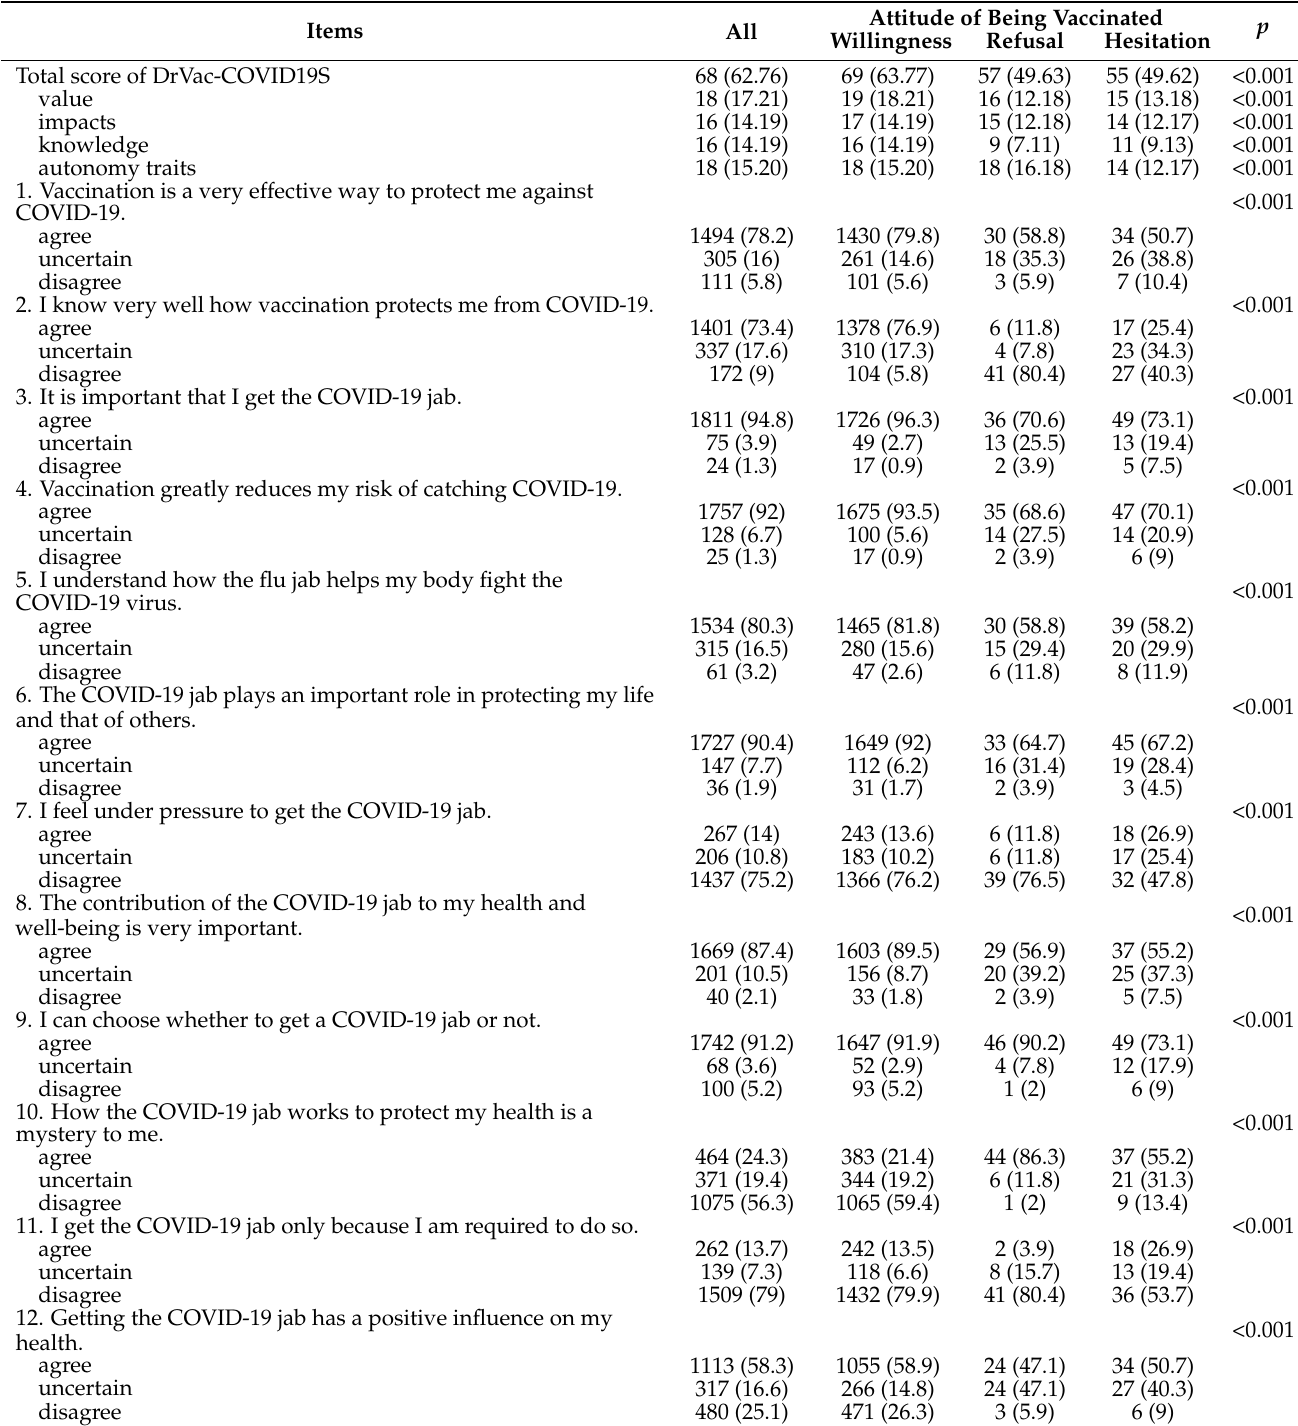
Attitude of Being Vaccinated p Willingness Refusal